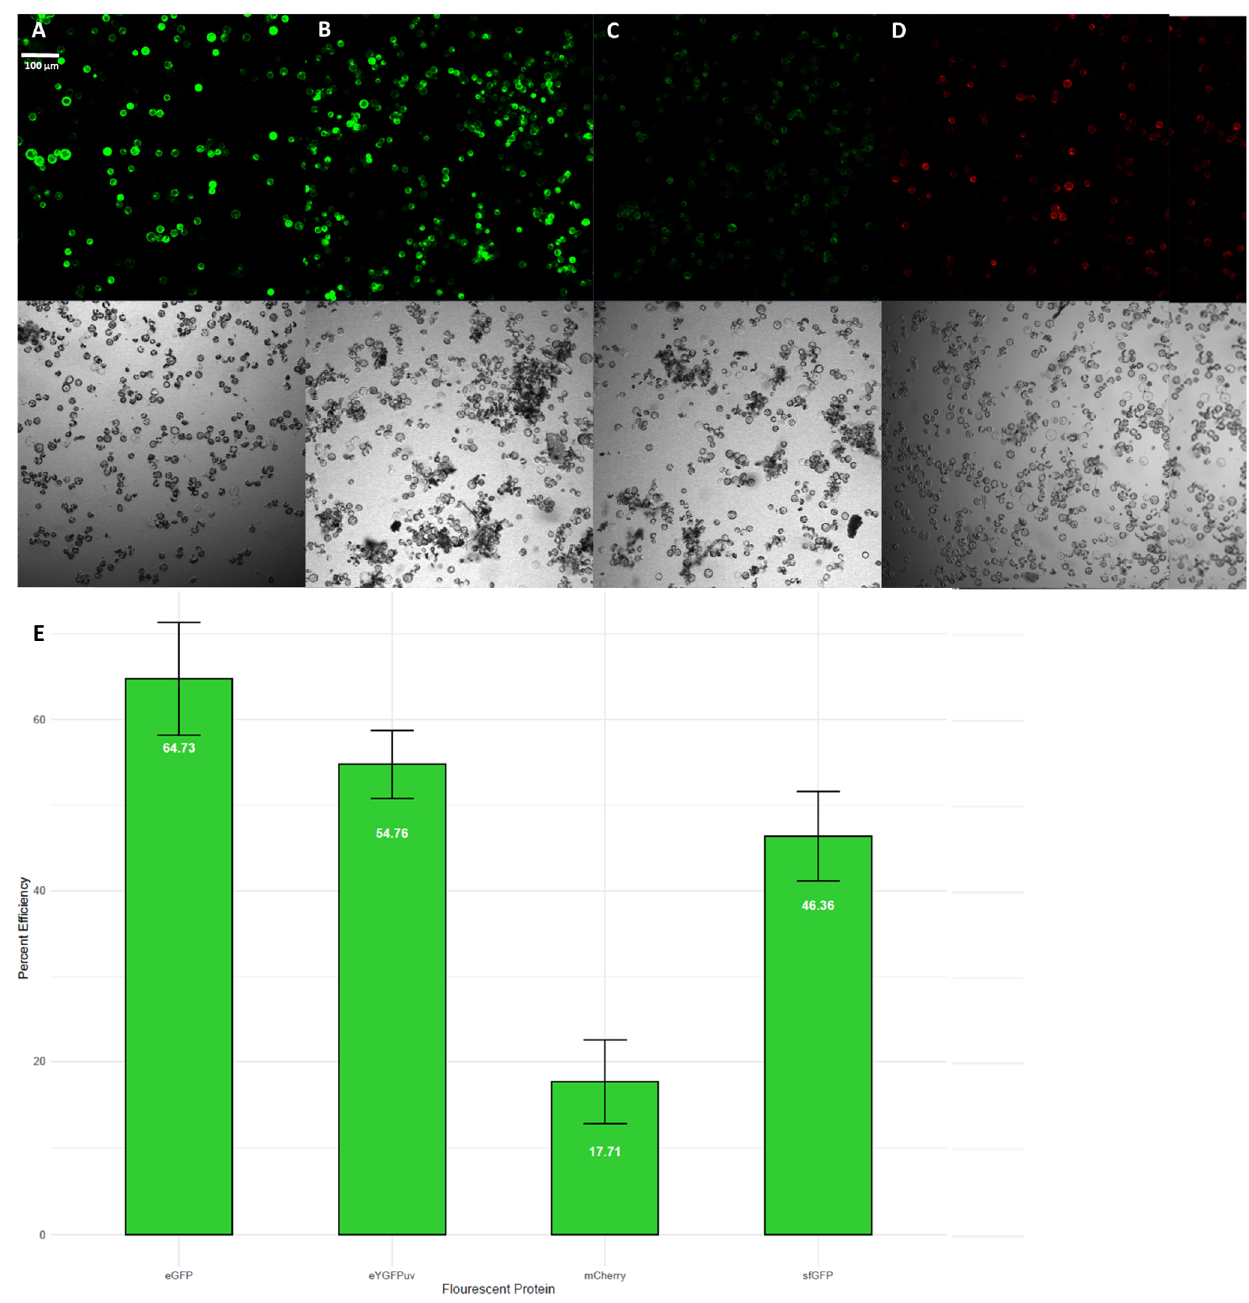
Figure 1. ( A ) sfGFP overexpression; ( B ) eGFP overexpression; ( C ) eYGFPuv overexpression; ( D ) mCherry overexpression; ( E ) percent transformation efficiency of each fluorescent protein tested shown as mean ± standard deviation of three independent scopes.